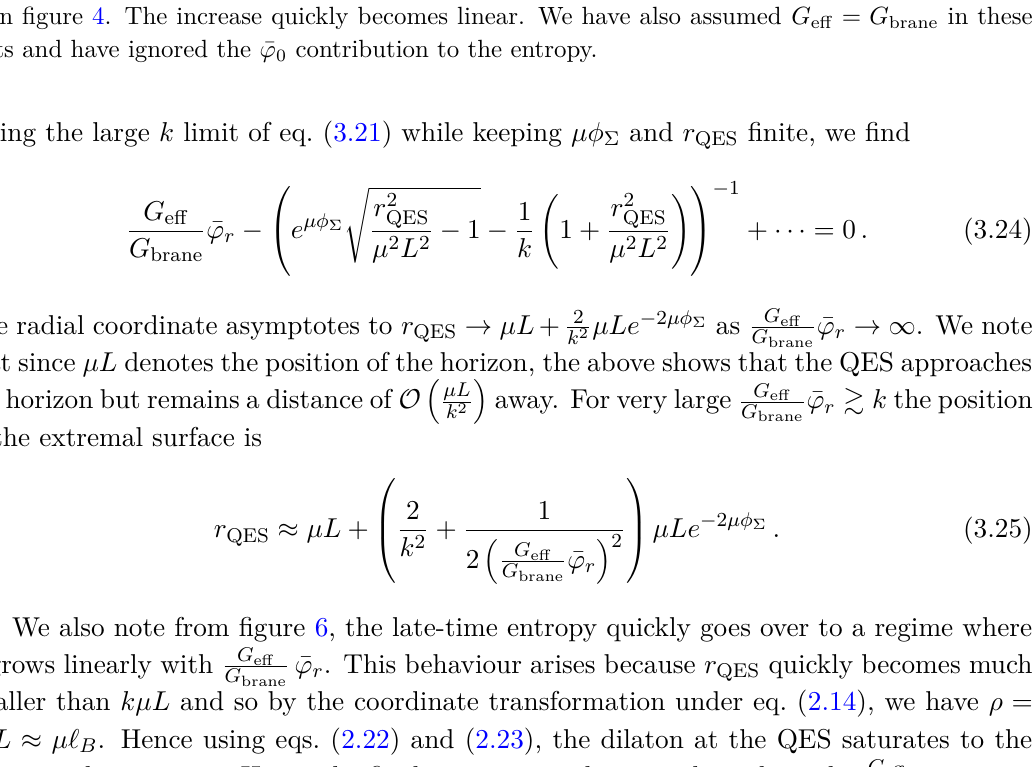
= G in these eff brane